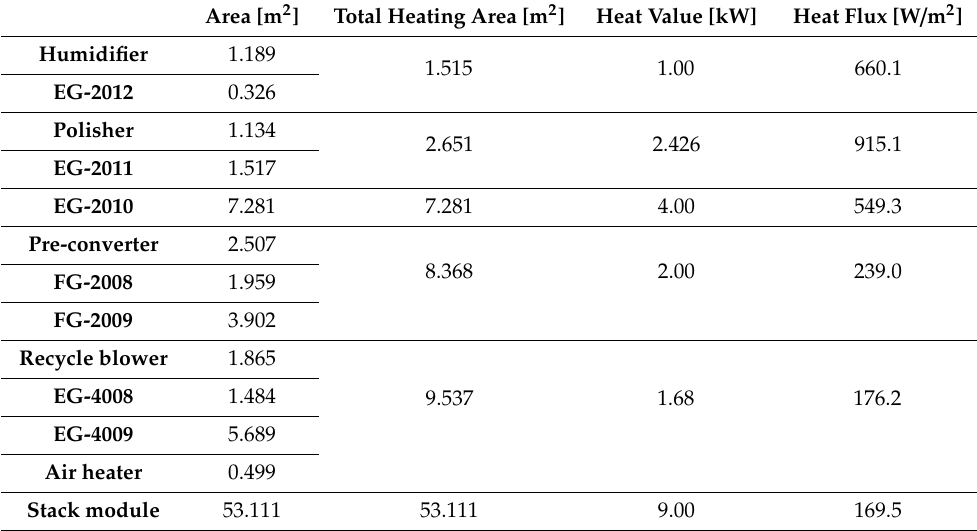
Figure 4. Leaked valve positions in the MCFC stack package. Table 1. Heat flux of the heating area of the stack package model.